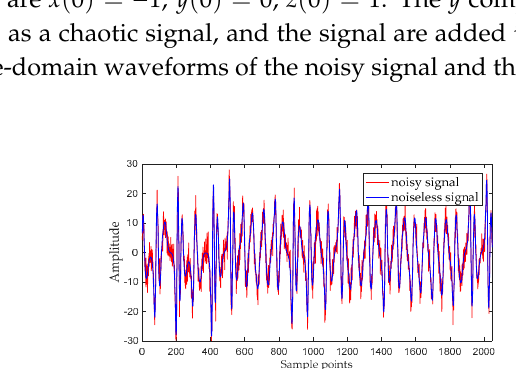
( b ) Figure 7. The decomposition result of MCEEMDAN. Table 3. The DEs of intrinsic mode functions (IMFs). IMF1